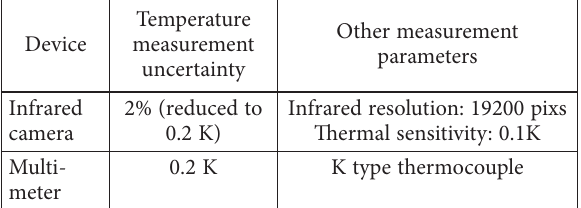
Table 1. Details of the measuring devices